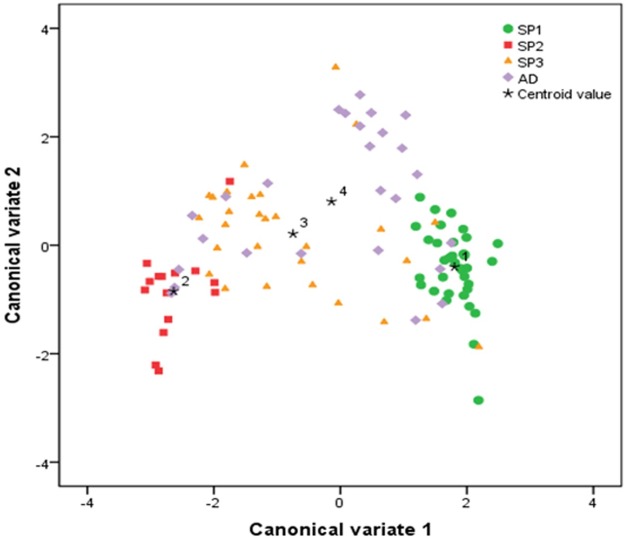
Scatterplot of the ILs belonging to different subpopulations based on the first two canonical discriminant functions.